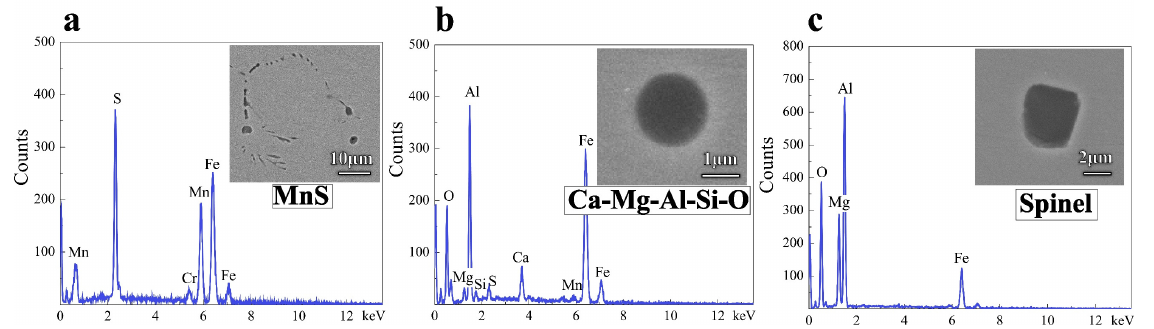
Figure 4. Typical morphology and composition of the inclusions observed in S0 sample. ( a ) MnS inclusion ( b ) Ca-Mg-Al-Si-O inclusion ( c ) Spinel inclusion.